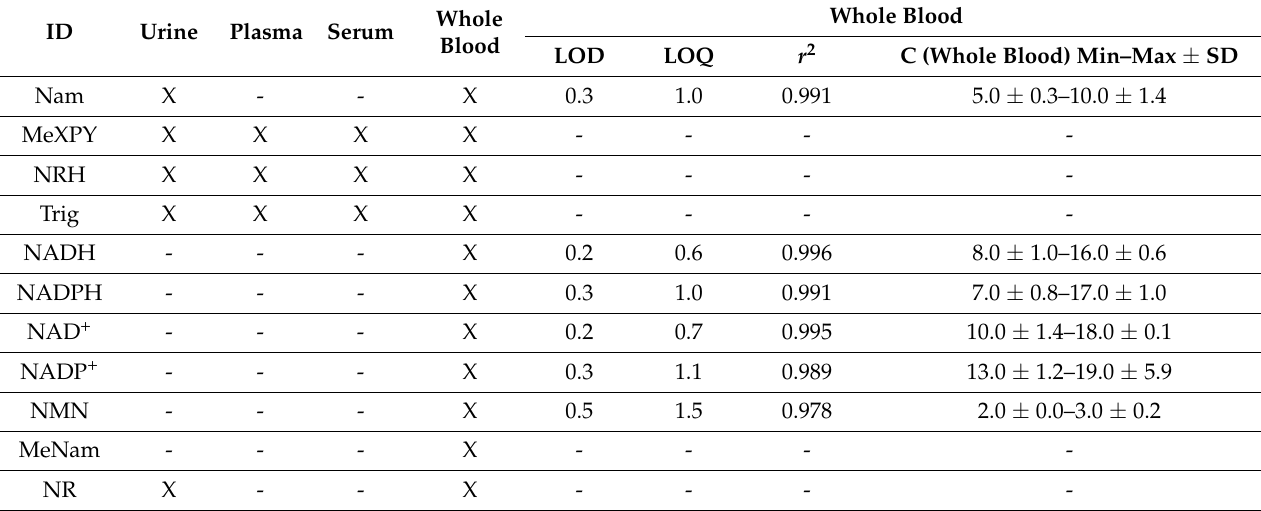
Table 2. NAD + metabolome of different human biofluids, and NAD + metabolome quantification in human whole